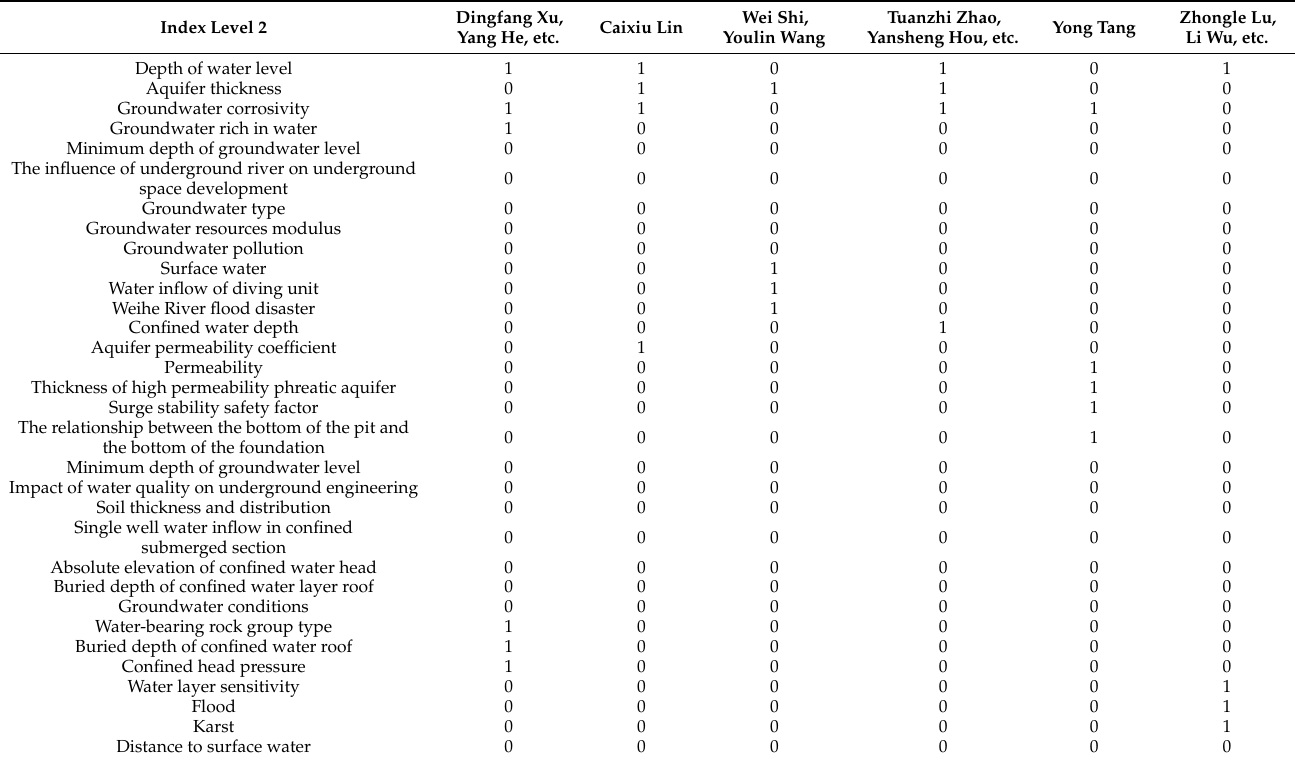
Table A12. Second level index binarization